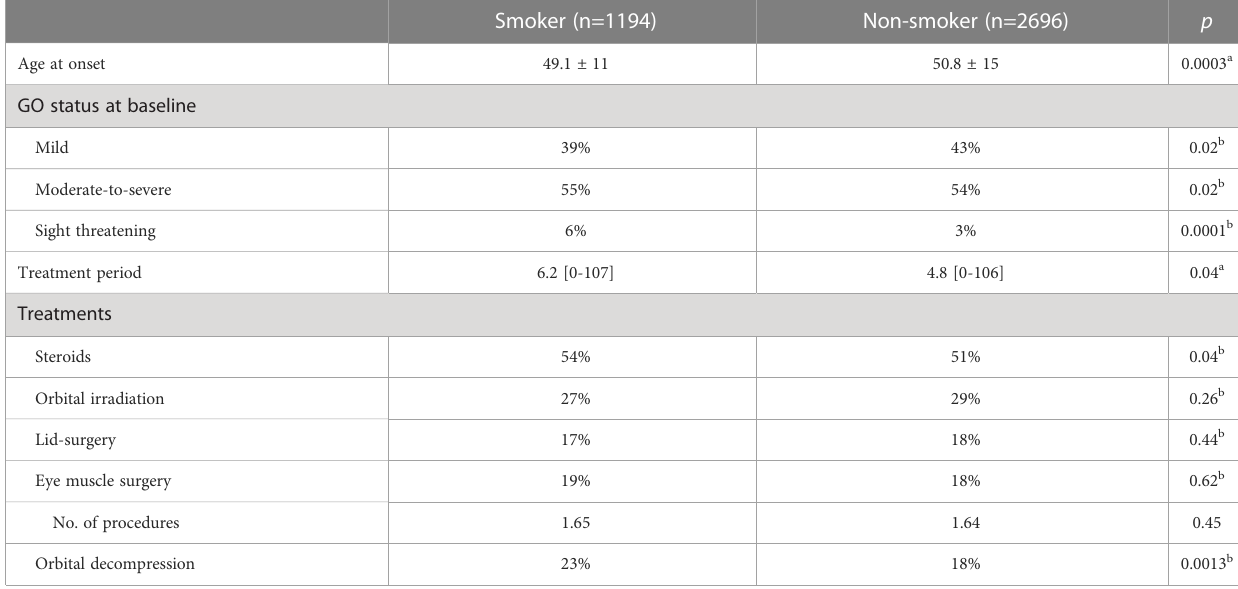
TABLE 2 Subgroup analysis of current smokers vs. non-smokers.